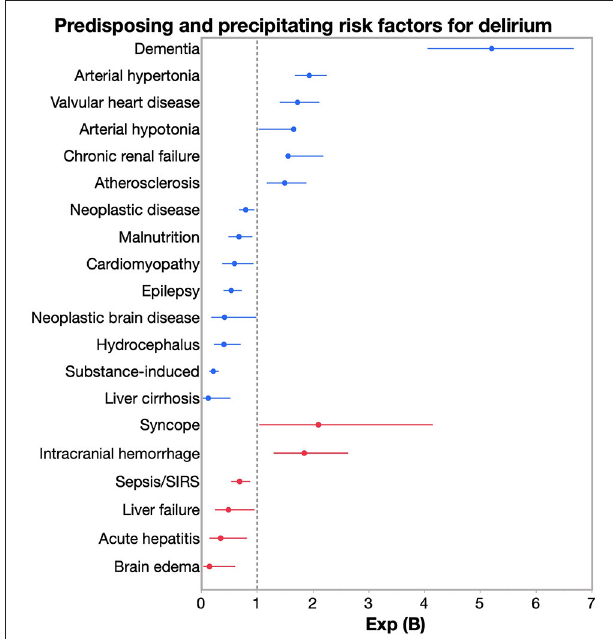
FIGURE 3 | Risk for developing delirium: Exp (B), confidential intervals (CI) for well-known predisposing (blue) and precipitating (red) risk factors. Corresponding regression coefficients [Exp (B)] at values > 1 indicate higher risks (e.g., dementia) in the very